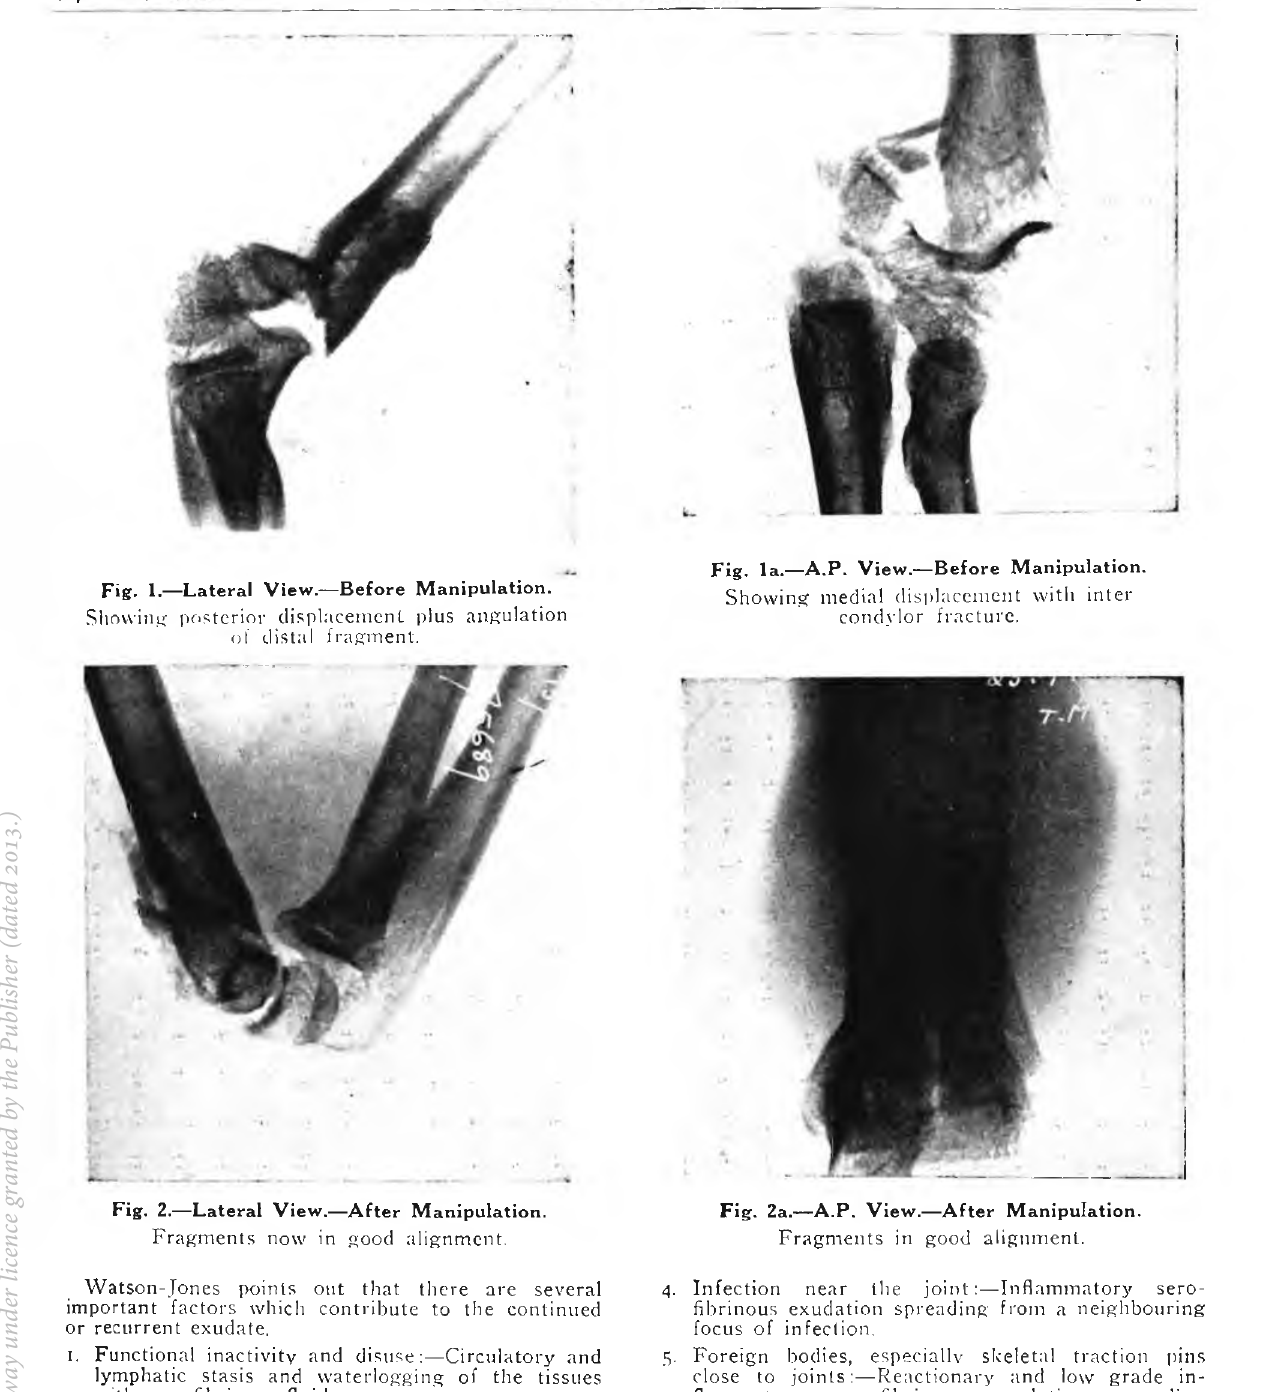
Fragments in good